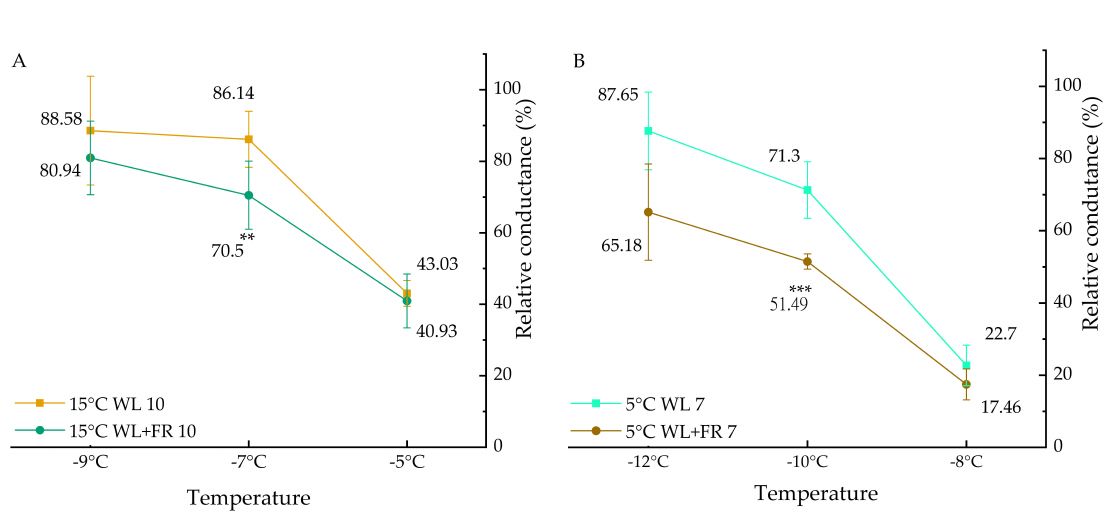
Figure 1. Relative conductance of barley leaf segments frozen at − 5, − 7 and − 9 ◦ C after incubation at 15 ◦ C for 10 days ( A ) and frozen at − 8, − 10 and − 12 ◦ C after incubation at 5 ◦ C for 7 days ( B ) under WL or WL + FR. Mean values ± SD of 5 independent biological repetitions are shown. Significance levels are designated as ** p < 0.05, *** p <